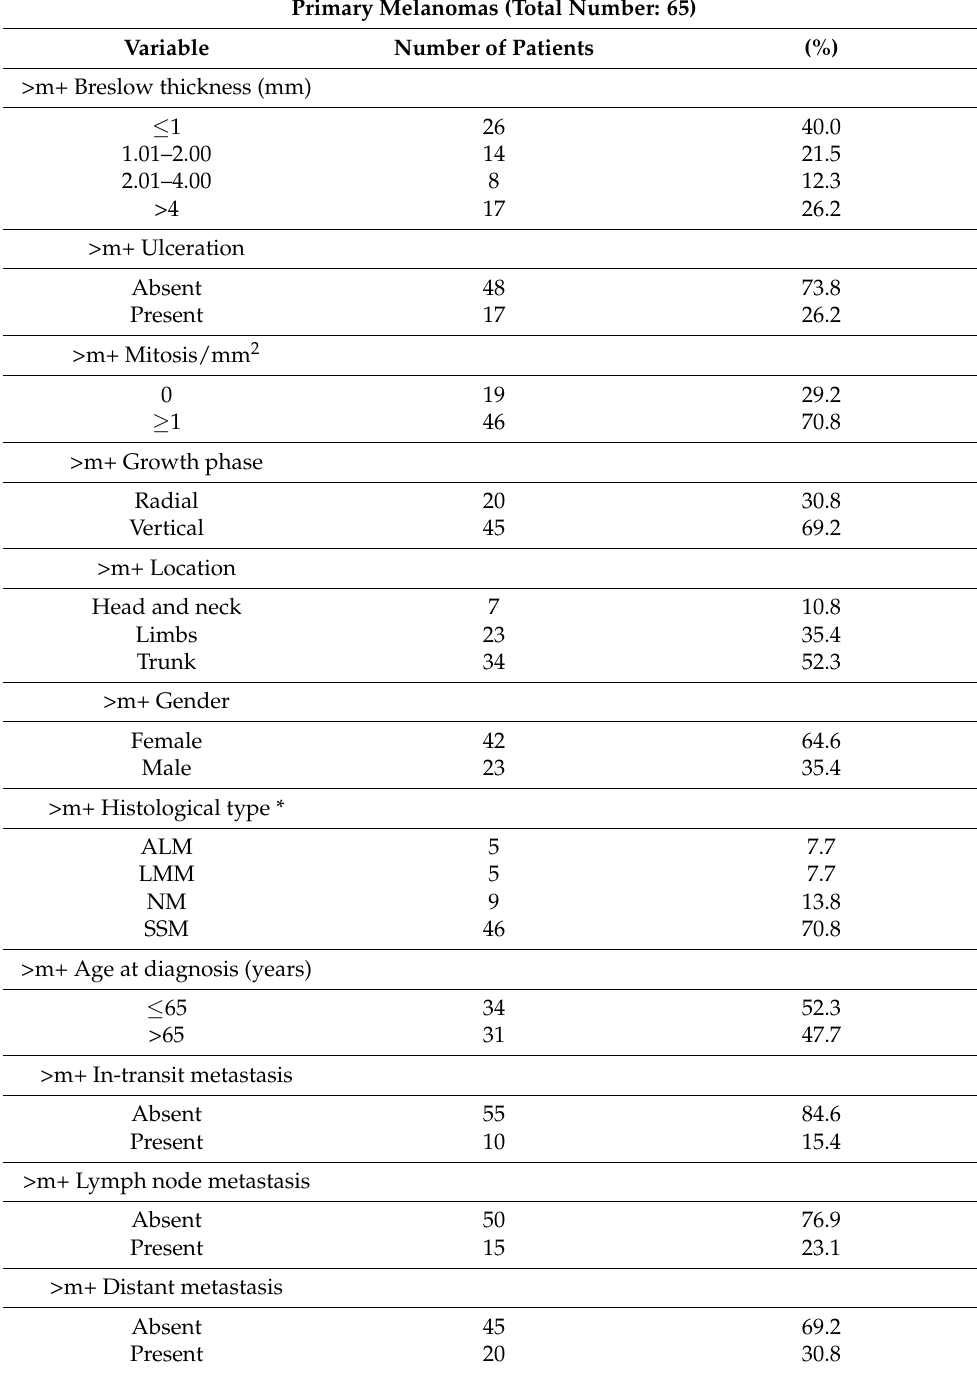
Table 1. Primary melanomas’ histological and clinical